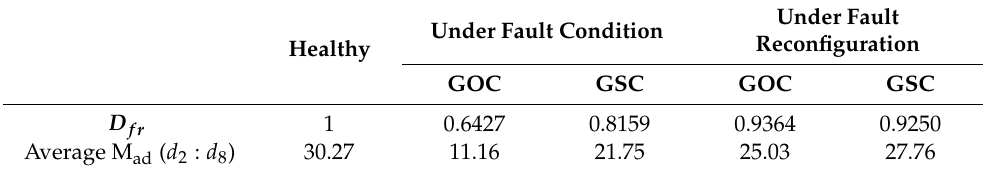
Table 5. Measured D fr values under healthy, faulty and reconfiguration conditions. Under Fault Condition Healthy